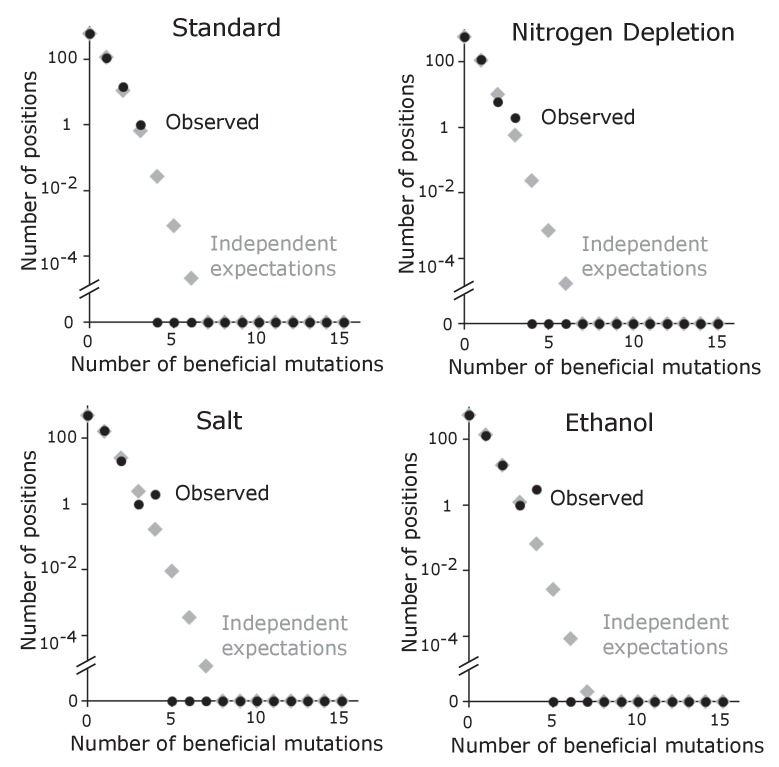
Distribution of the number of beneficial mutations at the same position in standard, nitrogen depletion, salt, and ethanol conditions.Independent expectations were calculated as the probability of the stated number of mutations occurring at the same position by chance.